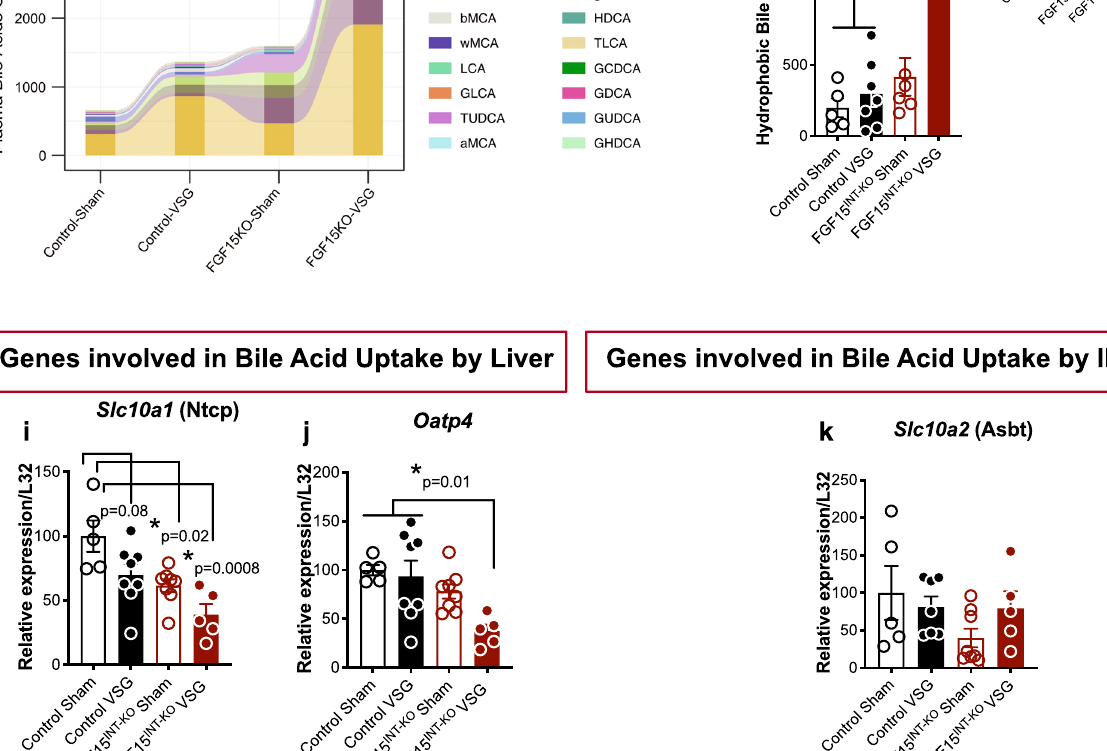
NATURE COMMUNICATIONS| (2021) 12:4768